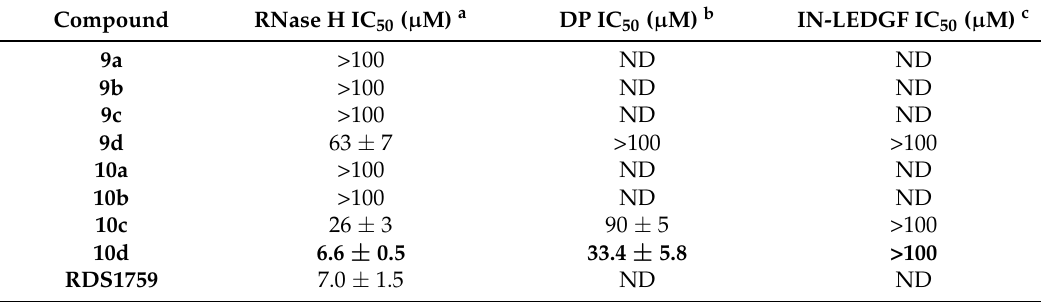
Table 1. HIV-1 RT-associated RNase H, RT-associated DNA polymerase, and HIV-1 IN inhibition activities for 9a – d and 10a – d , and the previously described inhibitor RDS1759 [14], used as reference compound. Compound RNase H IC 50 ( µ M)